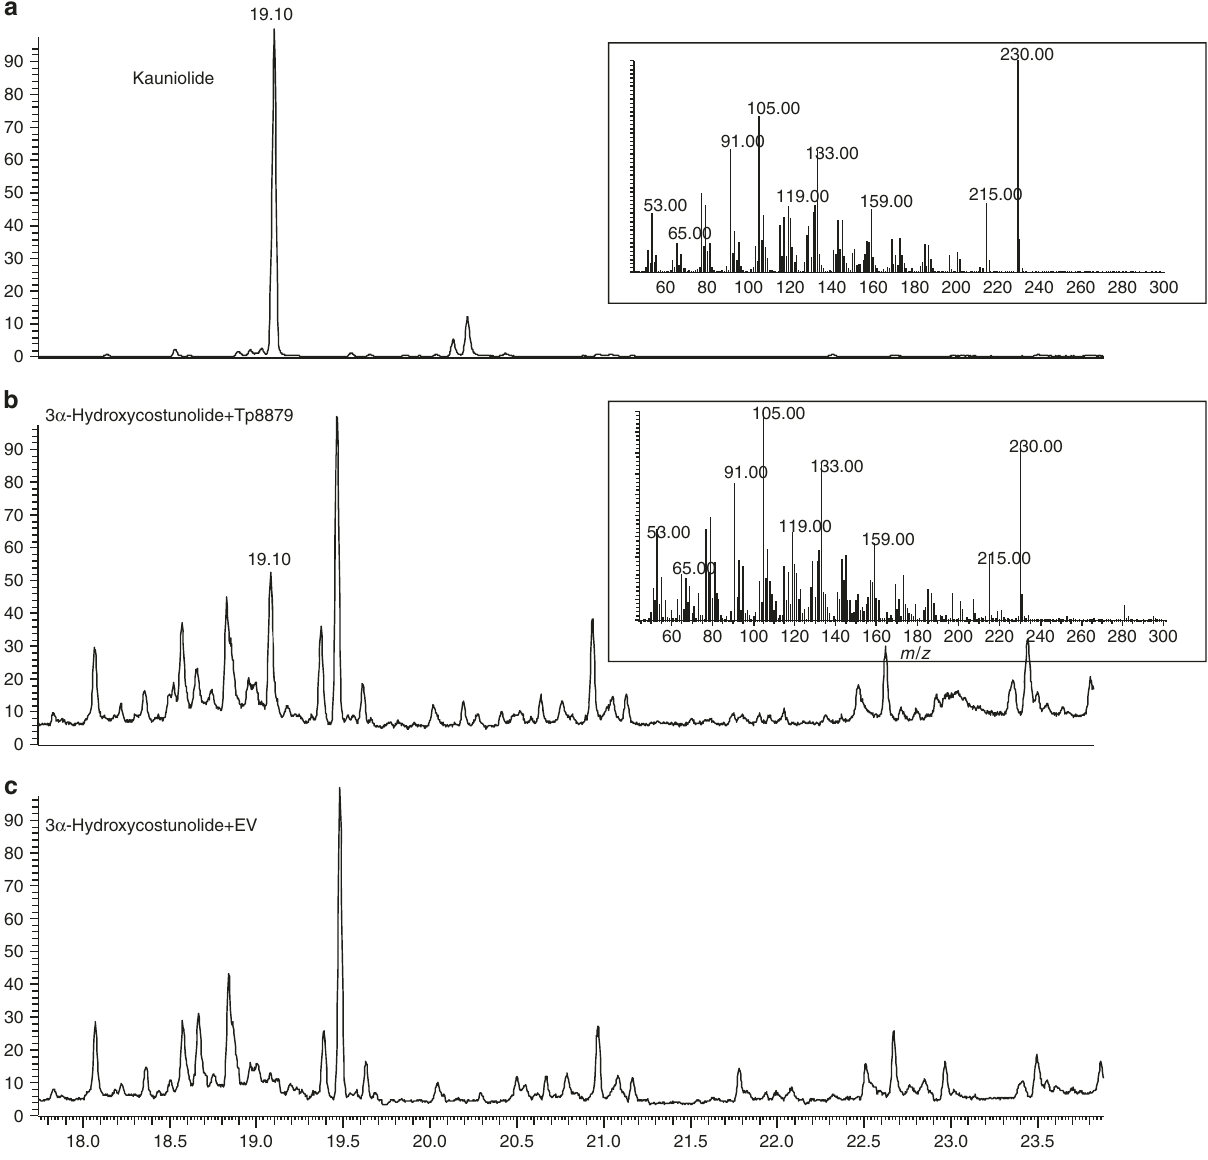
Fig. 4 The 3 α -hydroxycostunolide serves as the intermediate compound in kauniolide formation. a GC-MS chromatogram of kauniolide standard. b GC-MS chromatogram of product of assay with 3 α -hydroxycostunolide as substrate fed to yeast microsomes expressing Tp 8879: production of kauniolide (nominal mass 230). c Negative control; feeding 3 α -hydroxycostunolide to microsomes containing EV (microsomes of yeast with empty vector) does not lead to kauniolide